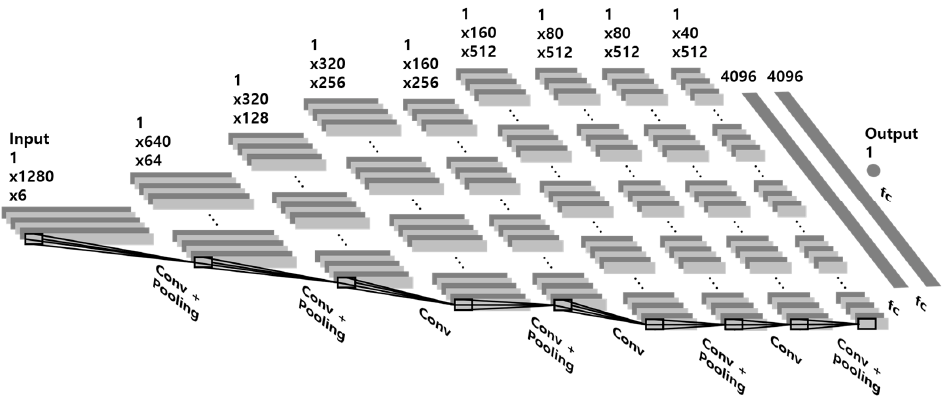
Figure 4. Baseline network architecture based on VGG-11.